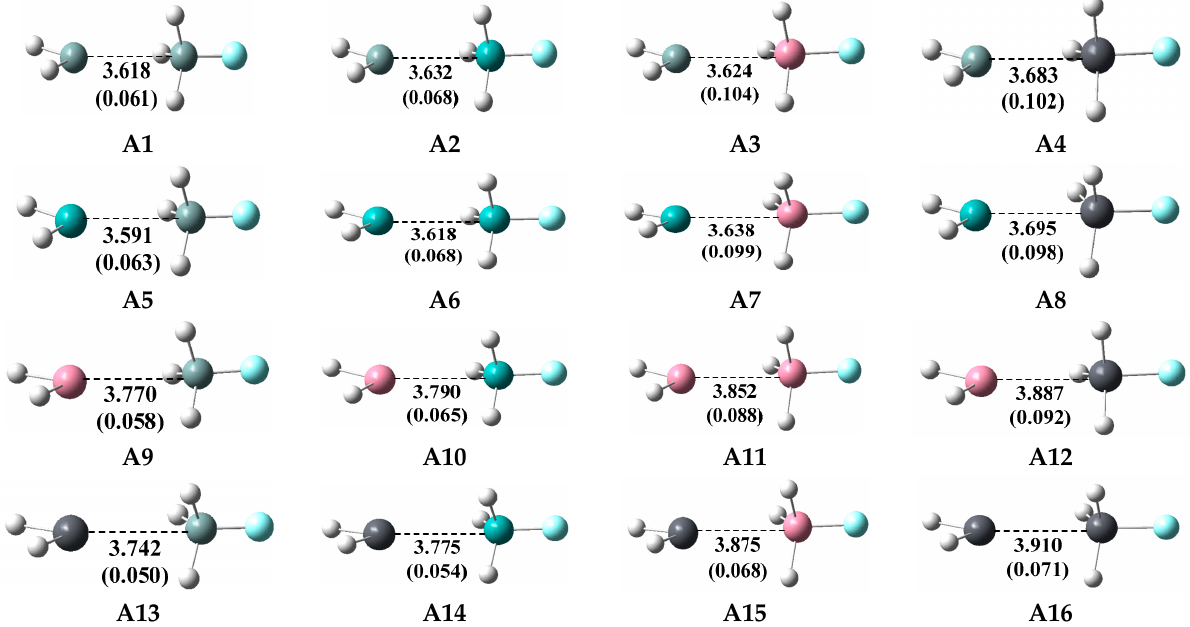
Figure 5. Optimized geometries of the type-A complexes at the MP2/aug-cc-pVDZ level, distances in Å, and WBI values (in parenthesis).